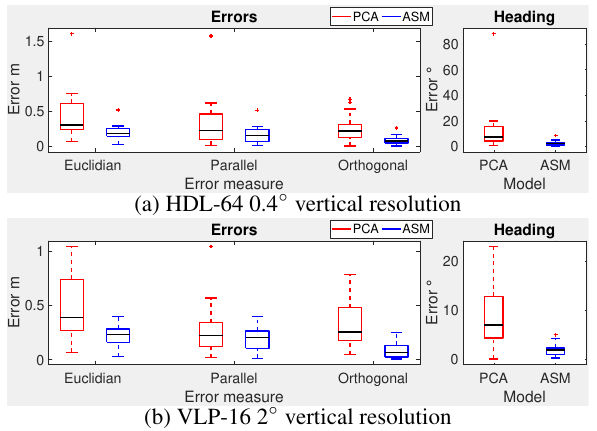
Figure 8. The mean error of the models for the van. Split in the total Euclidean error, the error along the van axis (left) and the heading error (right) difference for each considered scene. Independent of the res- olution using ASMs improves the detected poses in almost all scenarios. However, for the HDL-64/VLP-16 there are max- imal improvements of 1.38/0.64 m toward a maximal decline